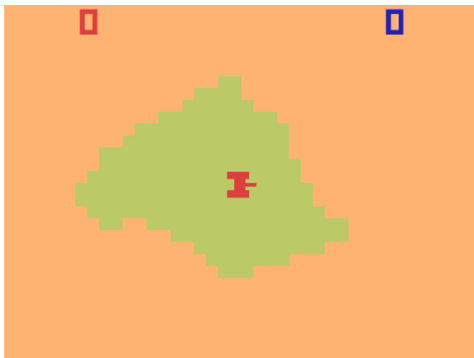
Figure 6. Not only is no tank representing the missing Anna visible here, there is no Anna in the source code itself.